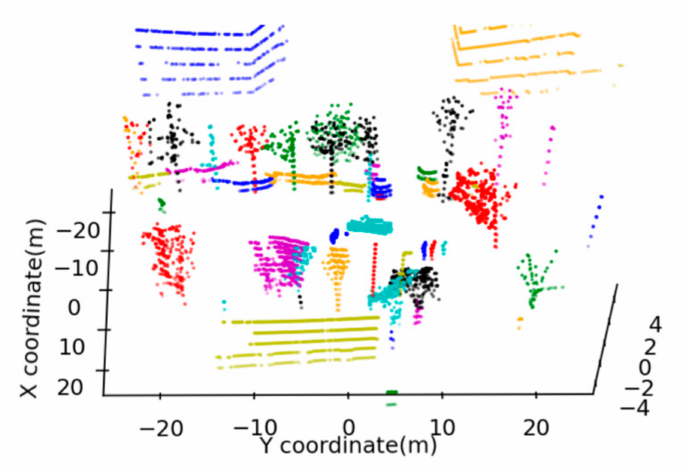
Figure 11. The results of instance segmentation, where colors are randomly generated and di ff erent colors of adjacent objects mean di ff erent classes.